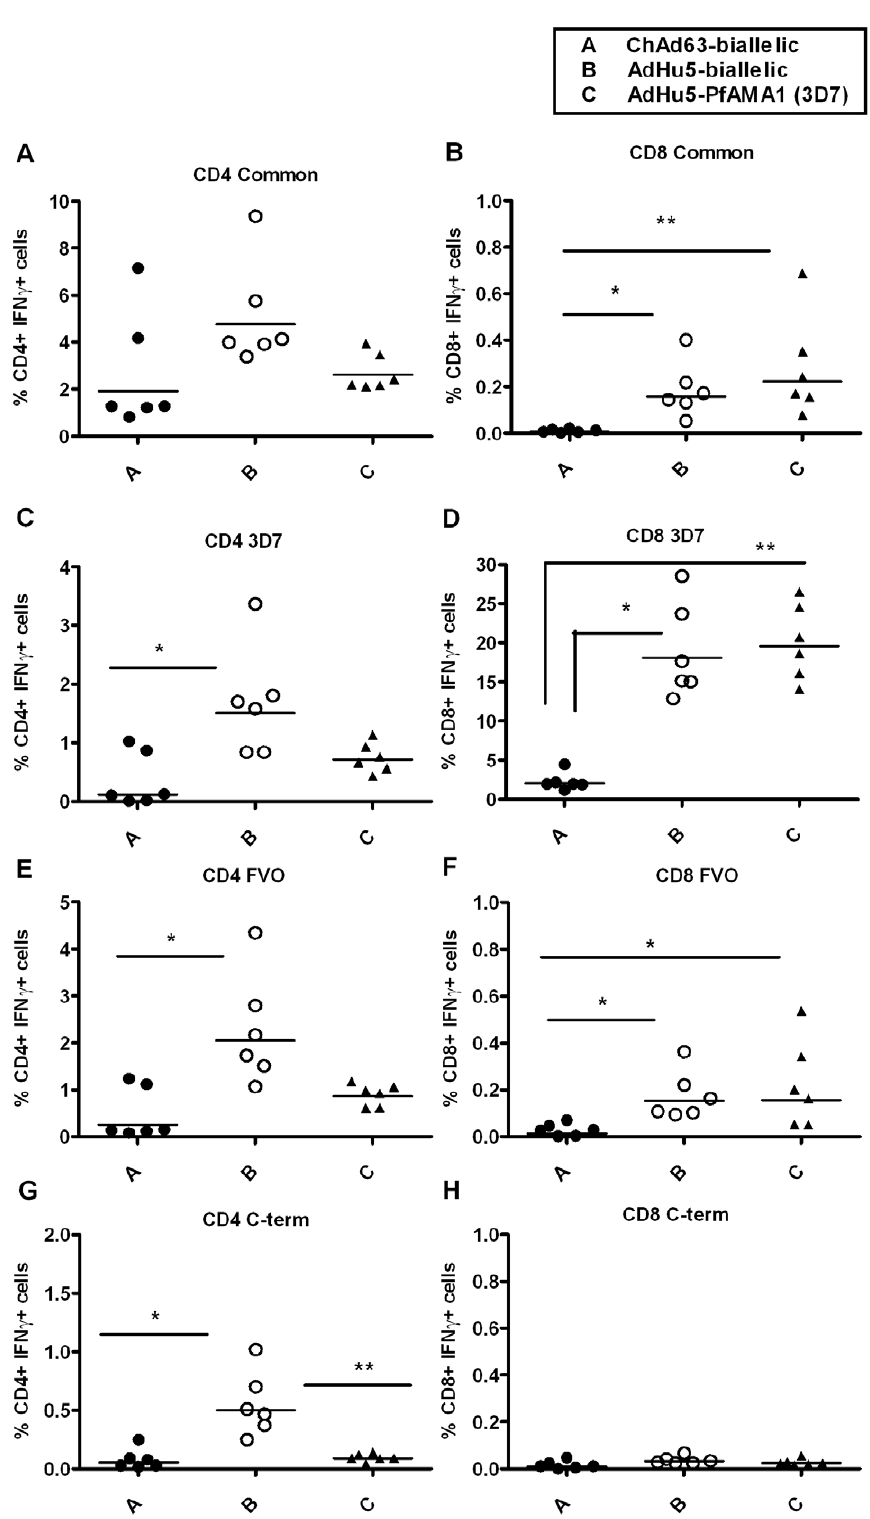
Figure 8. T cell responses induced in mice by vaccination with the mono-allelic and bi-allelic constructs. 5–6 week old female BALB/c mice ( n =6) were immunized as in Figure 6. Splenocytes were isolated two weeks after the final immunization (day 70) and stimulated with four peptide pools (Common, 3D7, FVO and C-terminus) or no peptide (Unstim) for 5 hours. After this time the cells were surface stained for CD4 and CD8 and then intracellularly stained for IFN- c , TNF a and IL-2 and analysed by flow cytometry for % of responding cells per total CD4 + or CD8 + T cell subset. % CD4 + and CD8 + T cells positive for IFN- c , TNF- a or IL-2 following the different vaccination regime is shown (8A-H). Individual data points and the median are shown. The asterisk indicates a significant difference between the groups by ANOVA (* P # 0.05, ** P # 0.01).